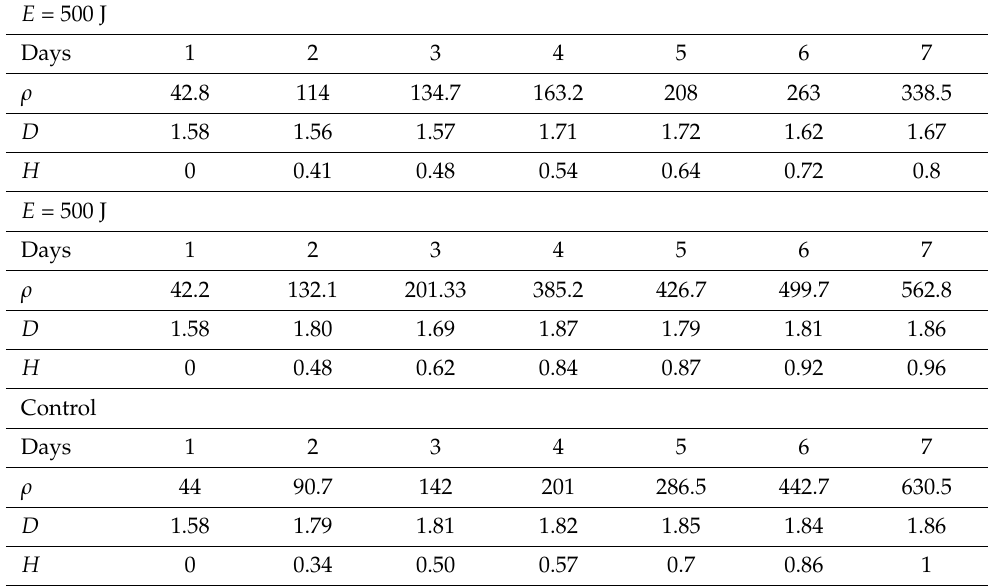
Table 4. Dynamics of entropy–structural criteria during pulsed magnetic action on human dermal